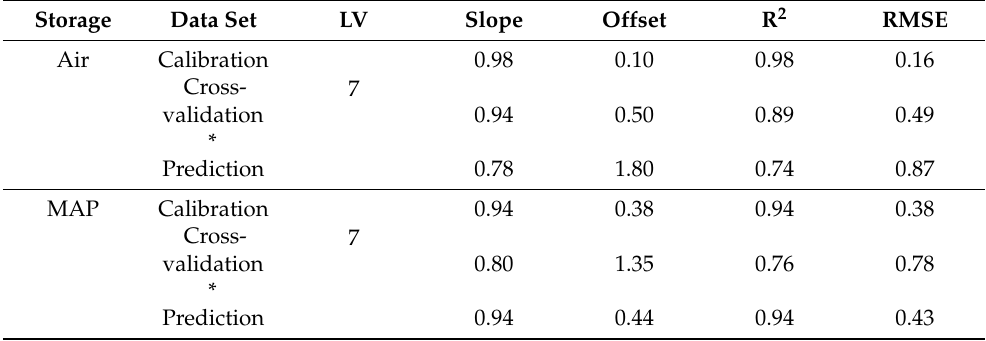
Table 2. Performance metrics of the PLS-R models developed on FT-IR data for the estimation of TVC in gilthead sea bream fillet